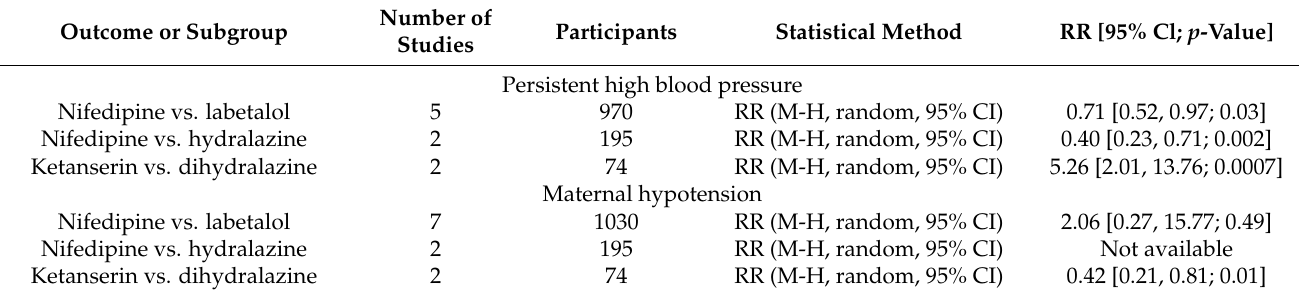
Table 4. Summary of meta-analysis comparing antihypertensive